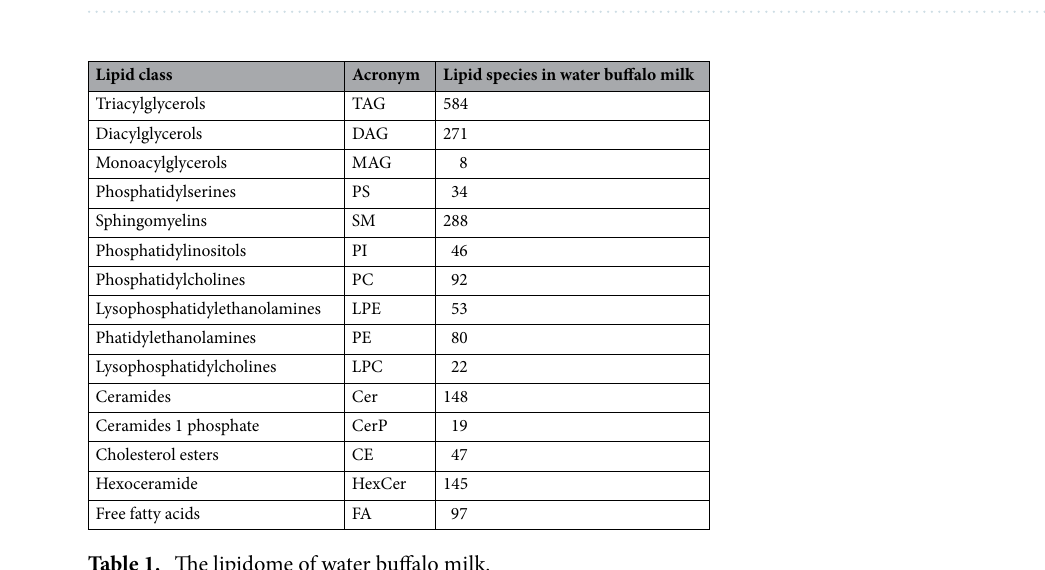
Figure 1. Schematic of the experimental design. Milk was collected from healthy and NAS-IMI quarters of water buffaloes and processed for lipidomic analysis through a liquid chromatography quadrupole time-of-flight (LC-Q-TOF) mass spectrometer. The figure was created using the web-based tool BioRender (https:// app. biore nder. com) to generate Fig. 1.